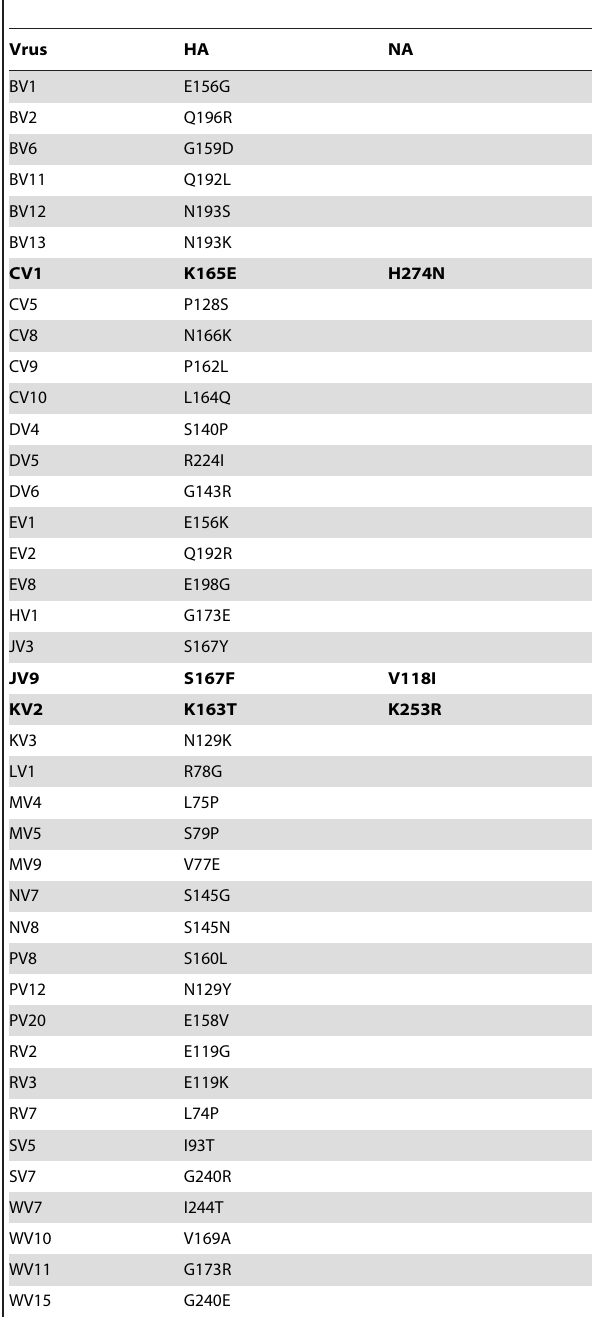
Table 1. Amino acid substitutions in HA mAb-selected